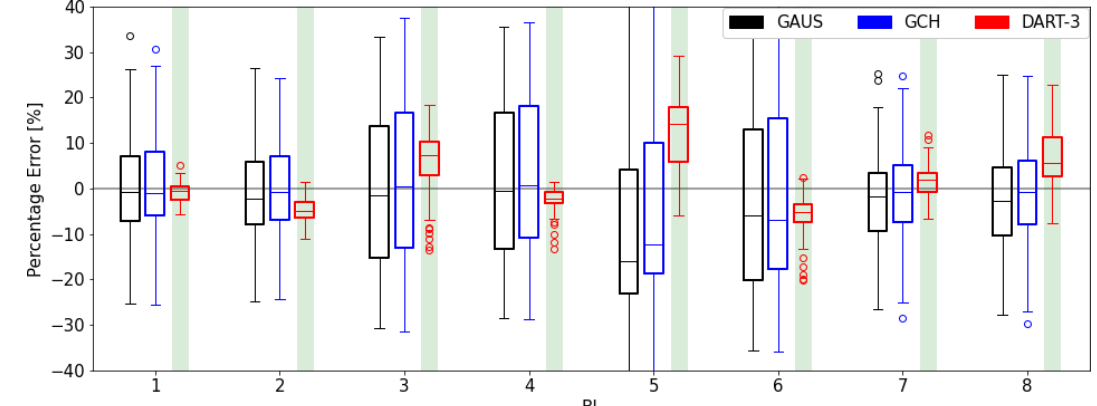
Figure 8. Performance of GAUS (black), GCH (blue) and DART-3 (red) using a leave-one-out cross-validation technique. Performance is displayed as a percentage error in available power. Each box includes data from 15 main simulations and 4D ≤ x ≤ 10D. The shaded areas again indicate a significant improvement (green), insignificant difference (yellow) or significant decline (red) in the accuracy of DART-3 compared to the benchmark